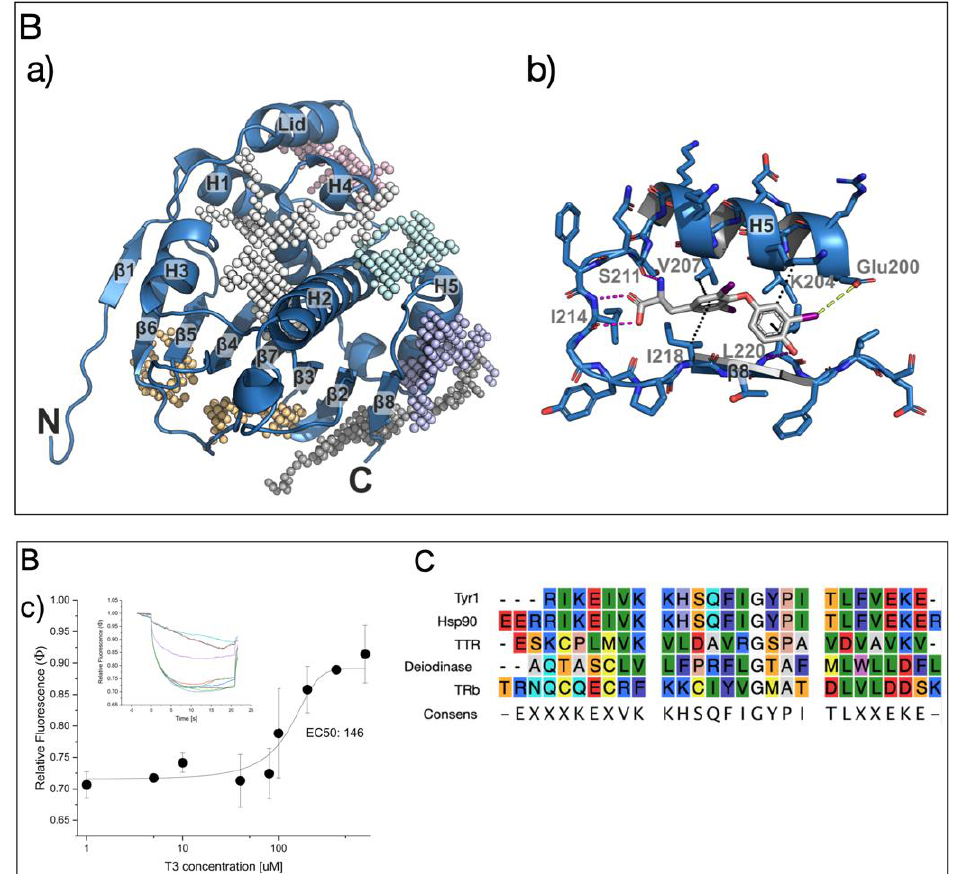
Figure 1. ( A ) Microarray-based analysis of T3 influence on Cy5-ATP binding on Hsp90. Monitoring of bound Cy5-ATP on Hsp90 without and with T3 (left) and corresponding dose-responsive binding activity (right). ( B ) Hsp90 N-terminal domain as binding target of T3: ( a ) overview of the Hsp90 N-terminal domain with identified binding pockets (colored meshes); ( b ) interactions of T3 to the residues of the binding pocket; ( c ) dose-responsive activity of T3 interaction on Tyr1 peptide by microscale thermophoresis analysis (MST). The dose-responsive fittings were performed with function y = A 1 + (A 2 − A 1 )/(1 + 10 (LOGx0 − x) × p) between the top and bottom asymptotes, with hill slope p and LOGx0 as center at indicated concentration x (inset). MST-traces of Cy5-labeled Tyr1 with increasing concentrations of T3 are displayed in the mode of thermophoresis + T-jump. Different concentrations of T3 are indicated by different colors of traces. Laser-induced temperature changes for F cold were applied from − 1 to 0 s, and for F hot , from 4 to 5 s. A control experiment with a bacterial HtpG from